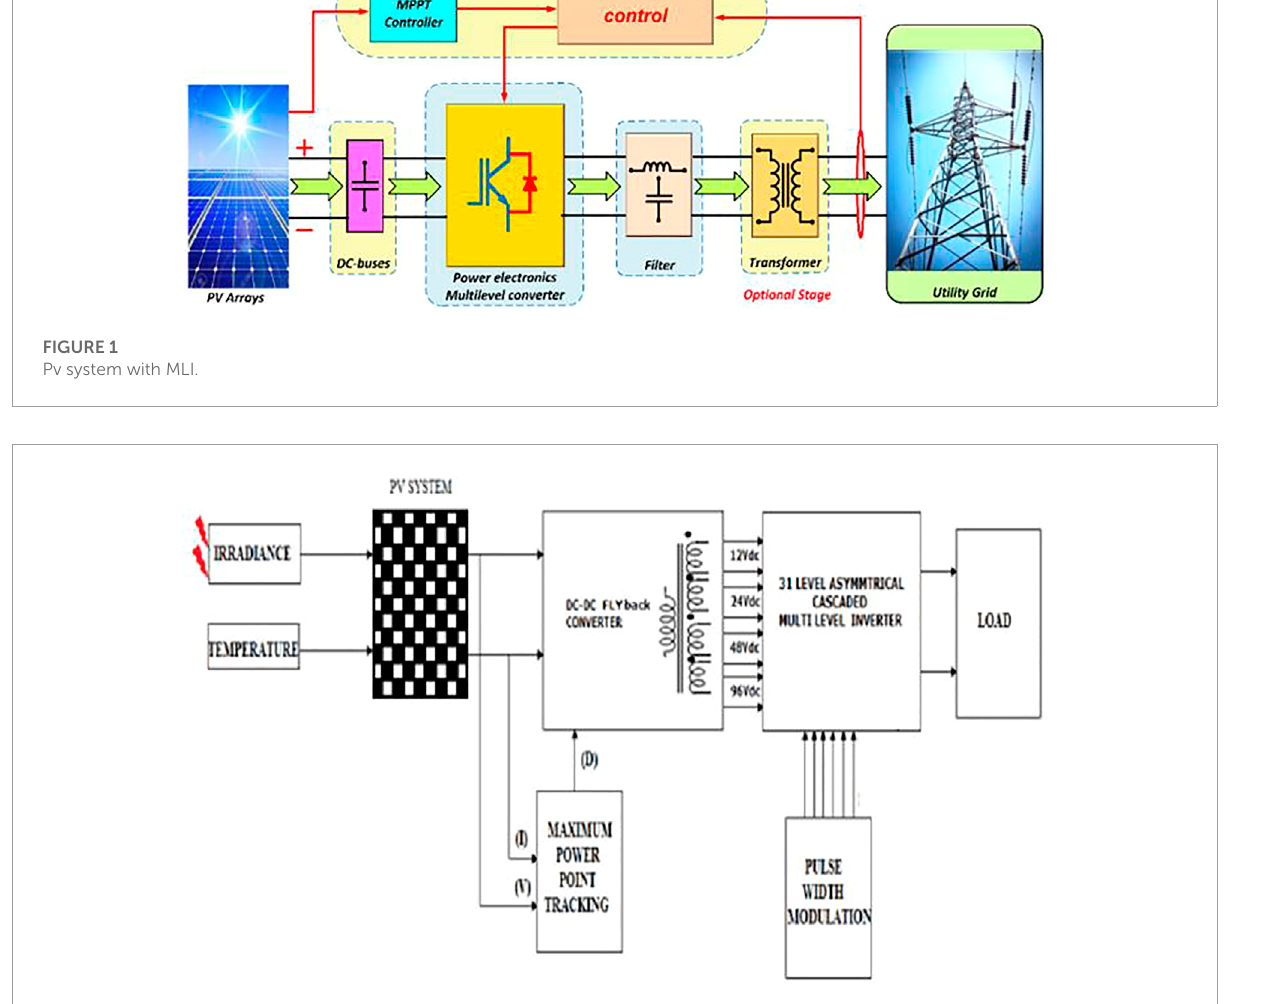
FIGURE 2 31-level proposed CMLI for the PV